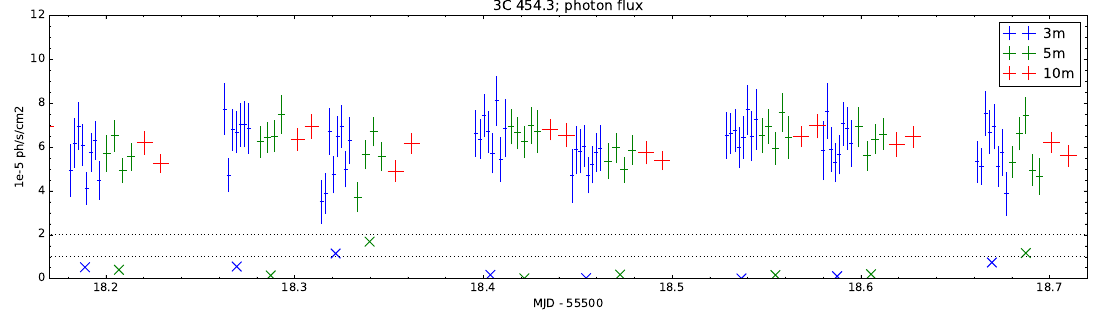
Figure 3. A section of light curves shown in Figure 2. The observation time for the cases of t min = 5,10 min (green, red) are shifted by + 0.018, + 0.036 d with respect to the case of t min = 3 min p , where p is the probability of steady intraorbit (blue). The ‘x’ marks indicate the value of − log 10